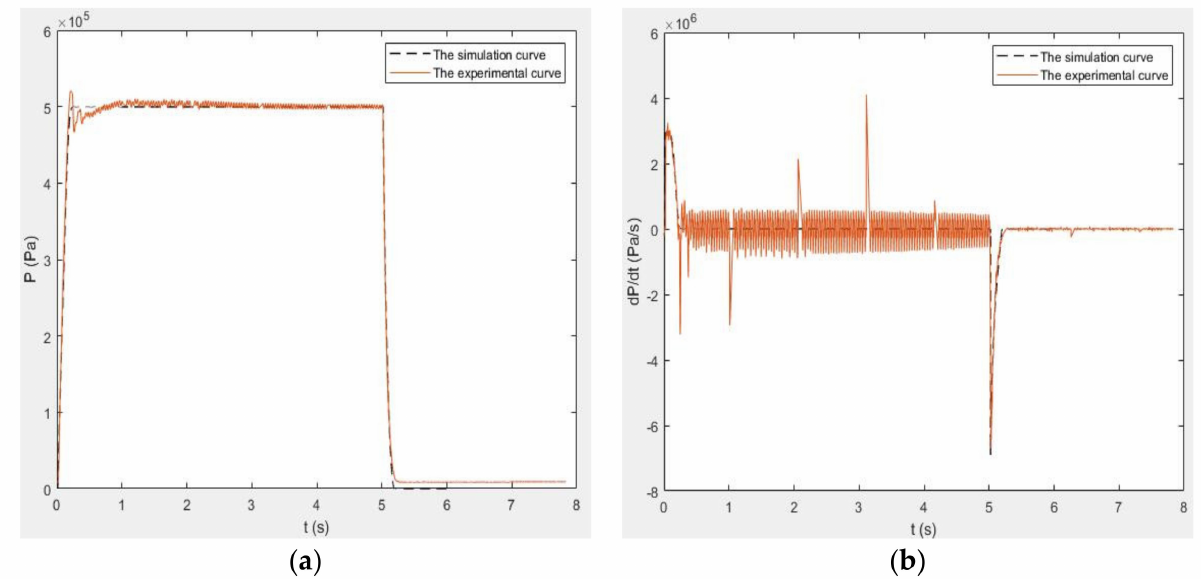
Figure 8. Pressurization and decompression response of an automatic pressure regulating valve: ( a ) pressure response; ( b ) pressure change rate